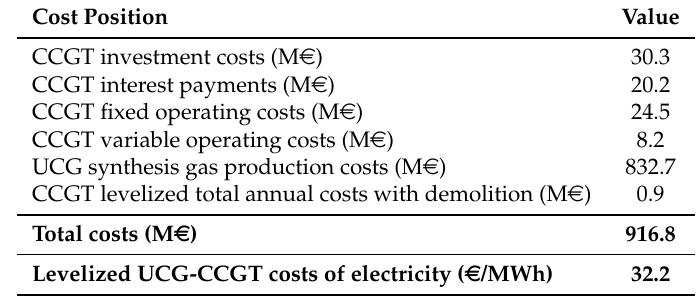
Table 11. Costs of all integrated UCG and CCGT process stages for 20 years of operation, combined as levelized costs of electricity